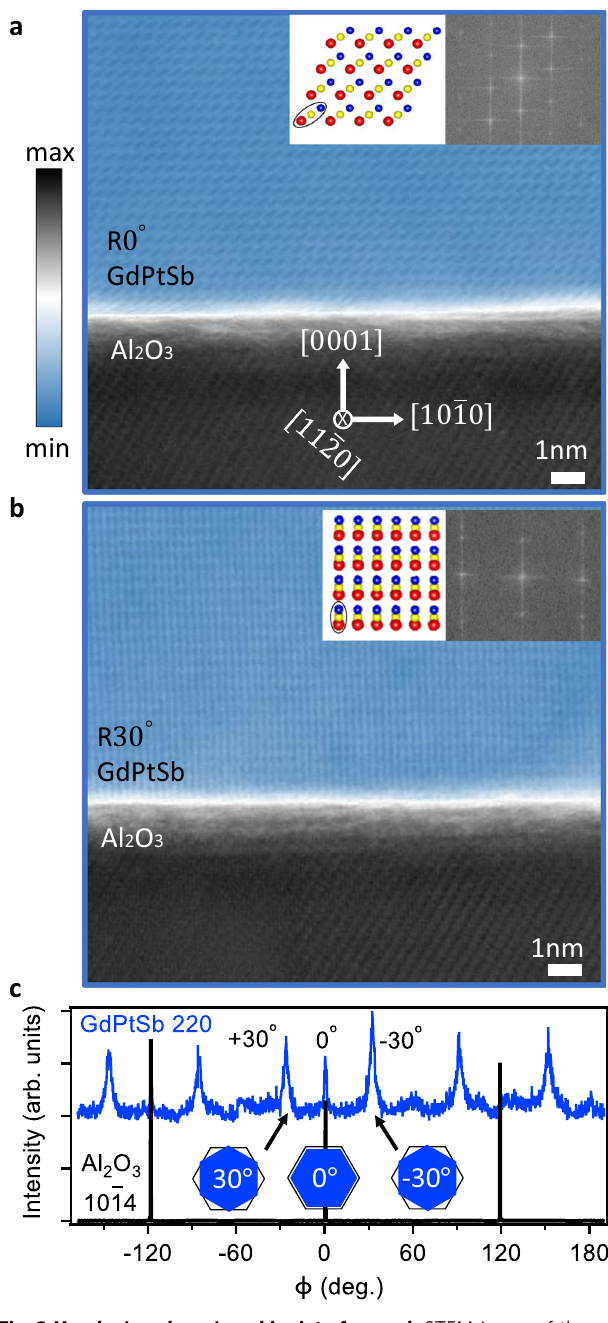
Fig. 3 Heusler/graphene/sapphire interface. a , b STEM image of the GdPtSb/graphene/Al 2 O 3 interface for the two different GdPtSb domains, as viewed along the h 11 (cid:1) 20 i Al zone axis. We used log scale false-color 2 O 3 image to simultaneously visualize the fi lm and substrate for better contrast. The insets show the schematic crystal structures and fast Fourier transforms of the STEM images. c In-plane ϕ scan of GdPtSb 220 re fl ections and Al 2 O 3 10 (cid:1) 14 re fl ections for GdPtSb sample grown on graphene/Al 2 O 3 . Δ ϕ = ±30° are the in-plane angles between the 〈 101 〉 direction of GdPtSb and the h 11 (cid:1) 20 i direction of Al 2 O 3